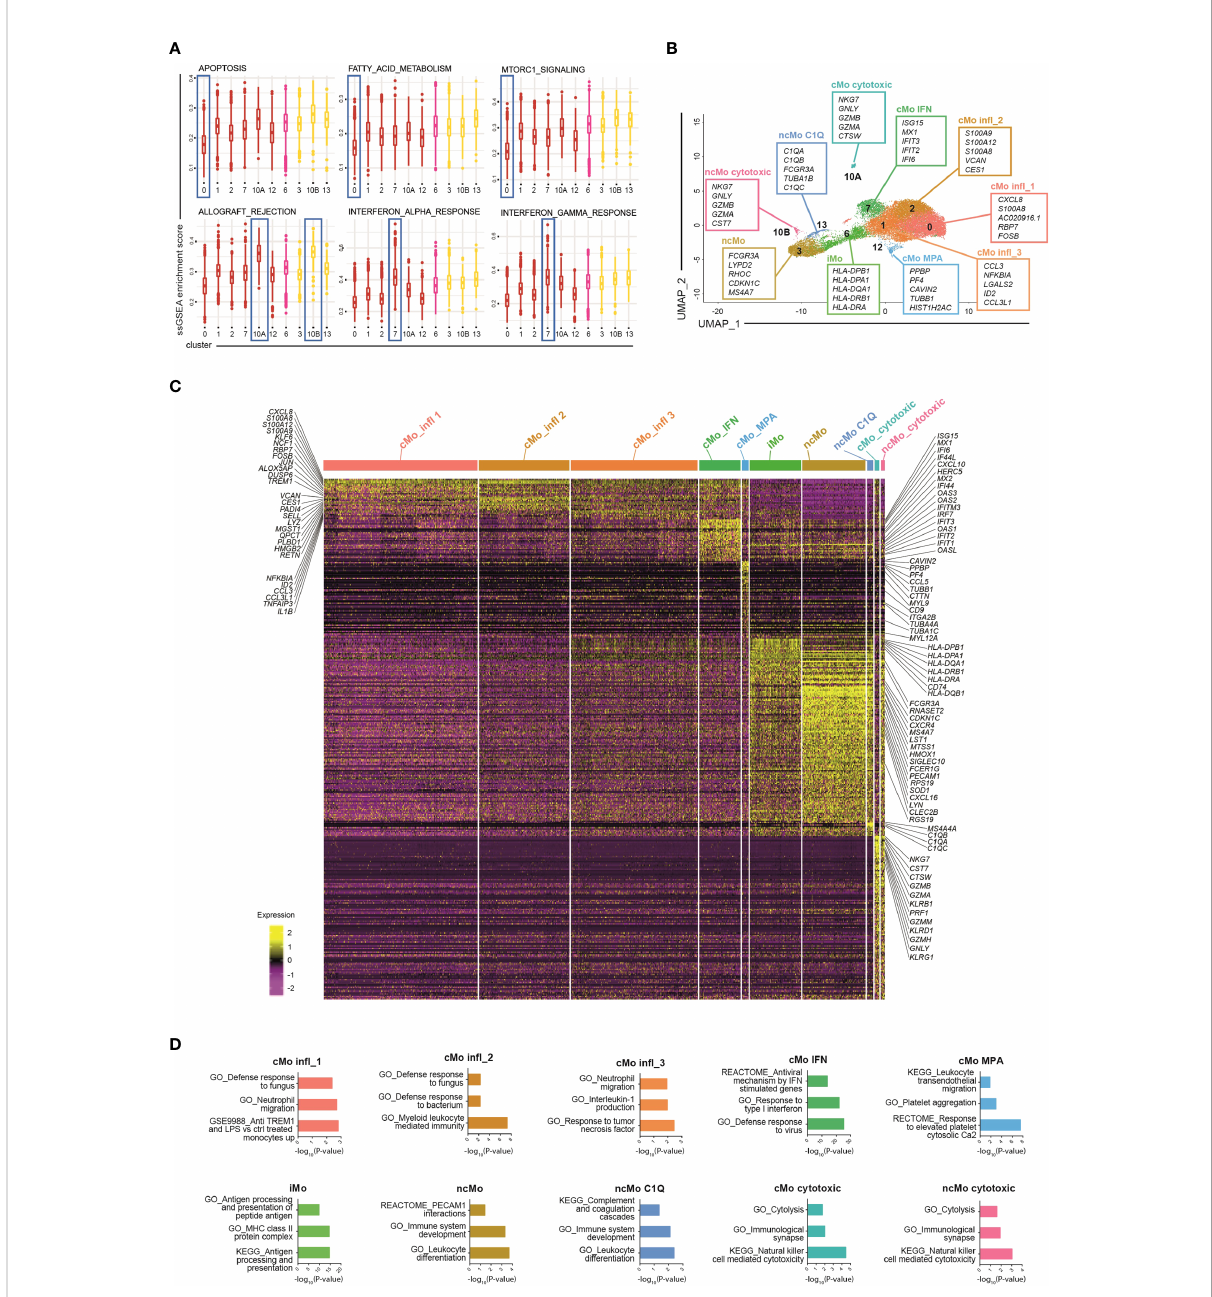
FIGURE 2 Phenotypic characterization of human blood monocytes in steady state conditions. (A) Boxplot showing the normalized enrichment score (ssGSEA) of selected Hallmark signatures found differentially enriched in clusters belonging to the same monocyte macro-group (classical and non-classical monocytes). Colour code: dark red, classical monocytes; pink, intermediate monocytes; yellow, non-classical monocytes. (B) UMAP projection of monocyte clusters (c0, c1, c2, c3, c6, c7, c10A, c10B, c12 and c13). Up to fi ve cluster marker genes are listed in boxes next to each cluster. Cluster marker genes are de fi ned as in Material and Methods. (C) Single cell gene expression heatmap showing signi fi cant differentially expressing genes ( pvalue adj ≤ 0.05, pct 1 ≥ 0.1, pct 2 ≥ 0.1, log 2 FC > 0.5) among monocyte cell subsets. Selected gene names are labeled; gene expression is colored-coded from purple (lower) to yellow (higher); gene expression level is scaled by row. (D) Pathway analysis of differentially expressed genes (one cluster of monocyte vs all the other monocyte cells). Bar plots show key canonical pathways collected in The Molecular Signatures Database (MSigDB) enriched in individual populations of monocytes. The Canonical Pathways gene sets derived from the KEGG pathway database, the Canonical Pathways gene sets derived from the Reactome pathway database and the Gene Ontology gene sets were taken into consideration. Only upregulated genes were